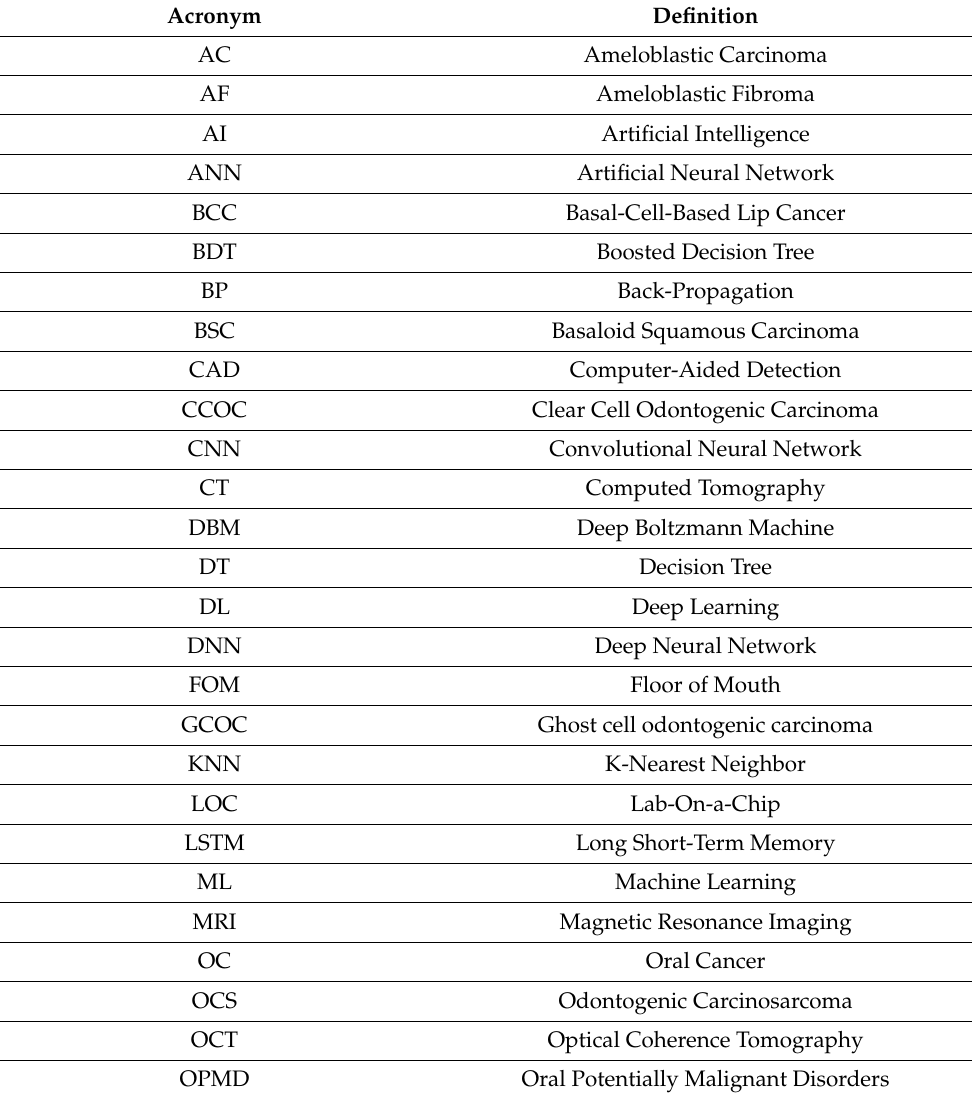
Table 1. A list of the acronyms used in this article along with their full